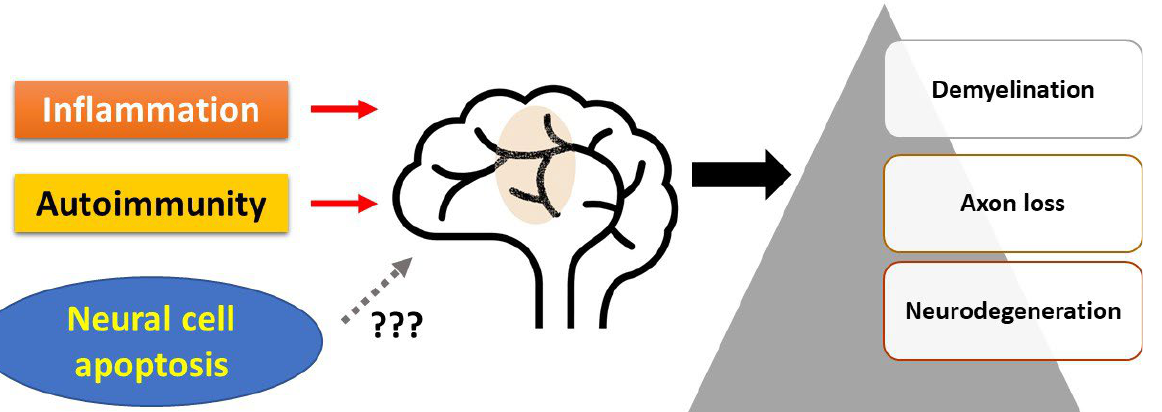
Figure 1. Current view of disease mechanisms of MS. It is usually considered that inflammation and autoimmunity in the CNS result in demyelination, axonal loss, and neurodegeneration. However, apoptosis of neural cells (oligodendrocytes and neurons) has been observed in MS lesions, and the contribution of this cell death process to disease pathogenesis remains to be determined .